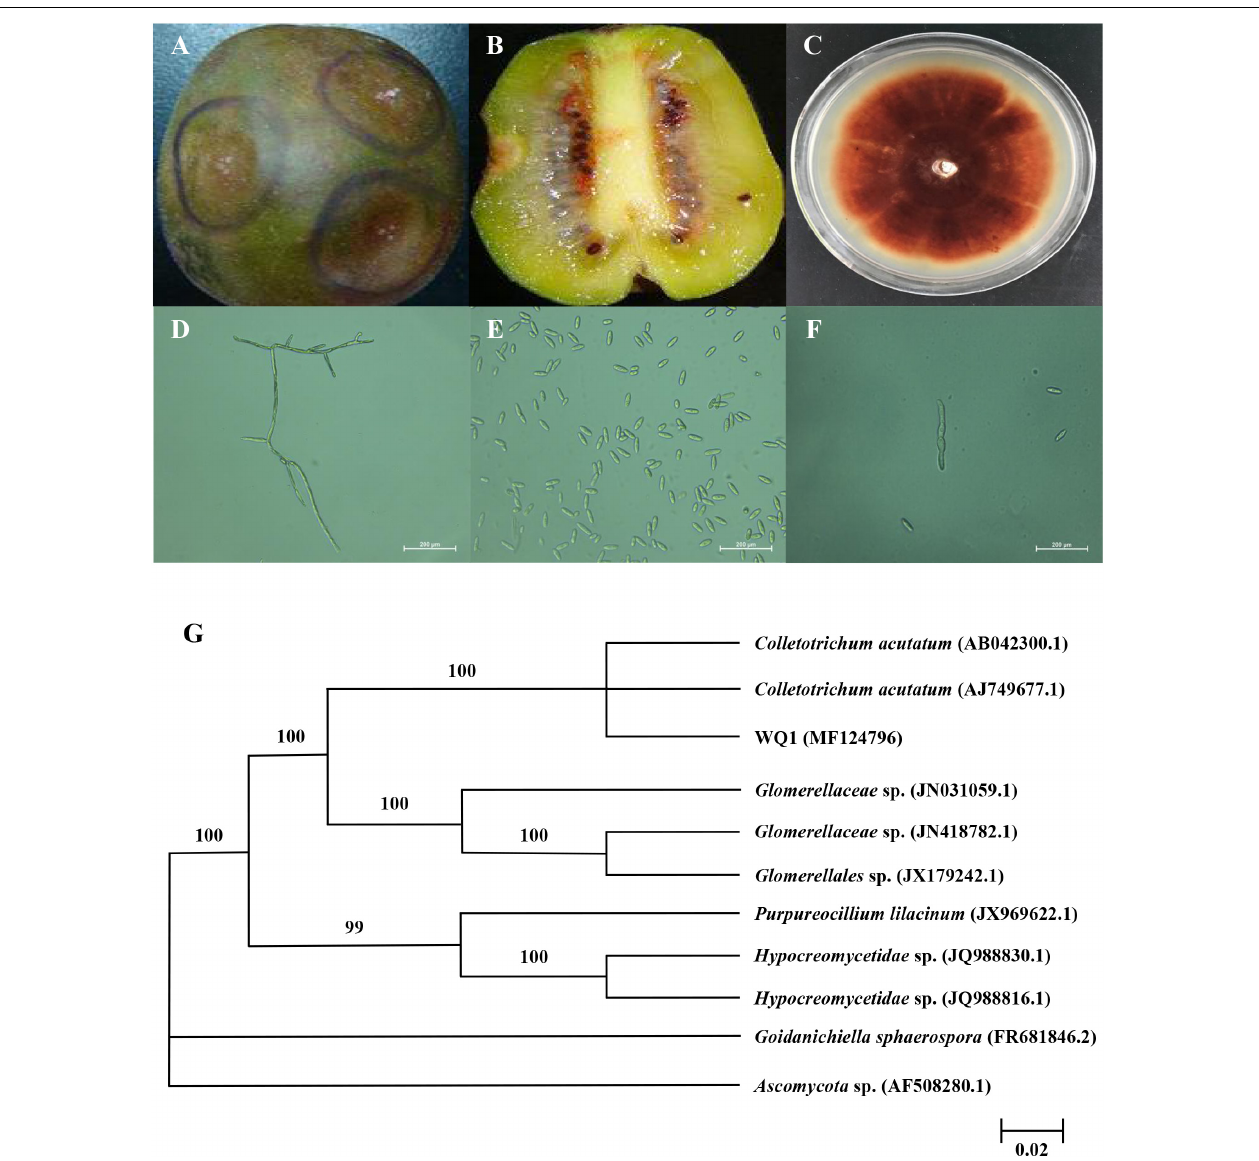
FIGURE 1 | Symptoms of kiwifruit anthracnose (A,B) , and cultural (C) and morphological (D–F) characteristics of isolated pathogen, as well as its phylogenetic tree (G). (A) Symptoms on the surface of diseased kiwifruit; (B) Symptoms inside of diseased kiwifruit; (C) Colonies of pathogen cultured for 7 days at 25 ◦ C; (D) Mycelia of pathogen and 400 × magnification; (E) Spores of pathogen and 400 × magnification; (F) Germinal spores and 400 × magnification; (G) Phylogenetic analysis of DNA sequences obtained from fragments of the ITS rDNA from the isolate along with the reference sequences from NCBI. The analysis was conducted using neighbor joining method. The scale bar represents 0.02% substitutions of